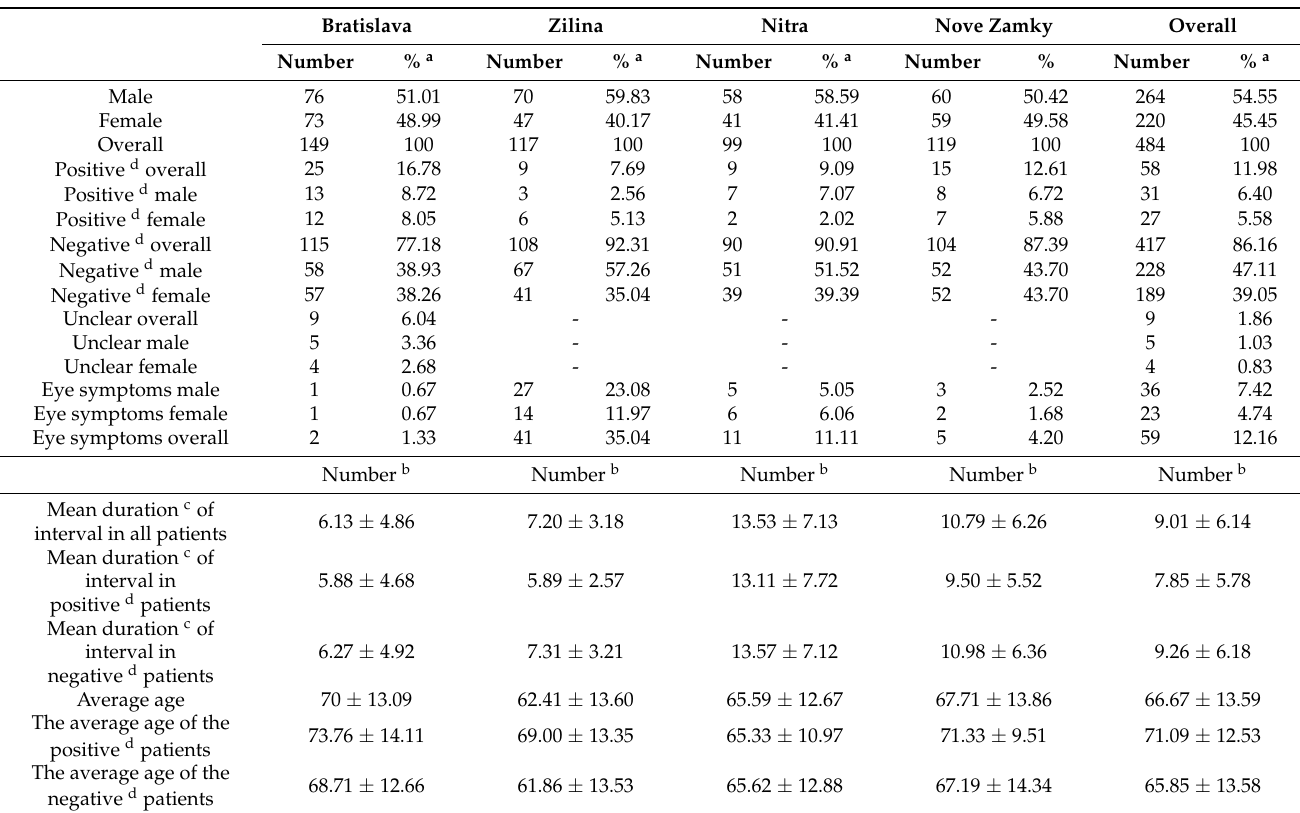
Table 5. Monitored parameters from four hospital centers (towns) and overall, with statistical